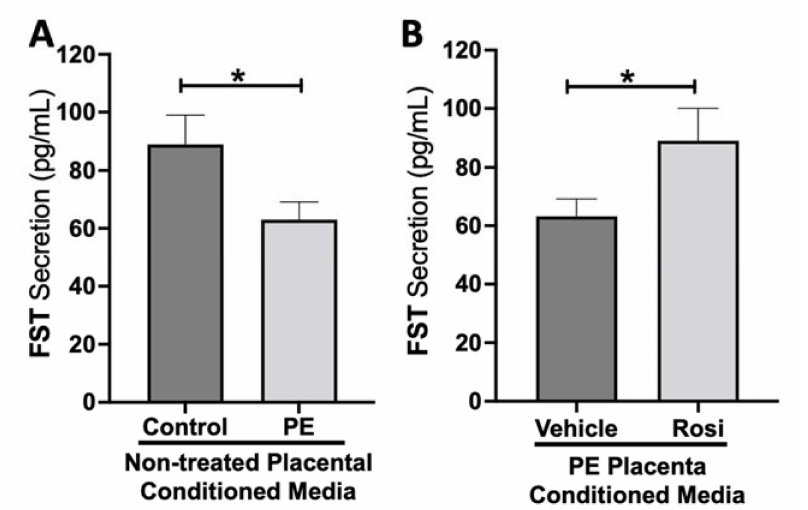
Figure 8. Follistatin shows reduced secretion from the preeclamptic placenta but is reversed by Rosiglitazone. Secretion of Follistatin (FST) was measured via Luminex assay from conditioned media from non-treated control and preeclamptic (PE) placentas ( A ) and vehicle- or Rosiglitazone (Rosi)-treated PE placentas ( B ). FST secretion was significantly reduced in the PE placenta compared to control placentas ( A , n > 10) however, Rosi treatment led to a significantly increased secretion of FST from the PE placenta compared to vehicle-treated PE placentas ( B , n = 14). (Protein secretion was measured by a Luminex assay where experimental values were determined relative to a standard curve. Statistical analysis was performed by student’s t -test to determine significant differences between groups, * p < 0.05, bar plots and data reported are reported as mean pg/mL values ±